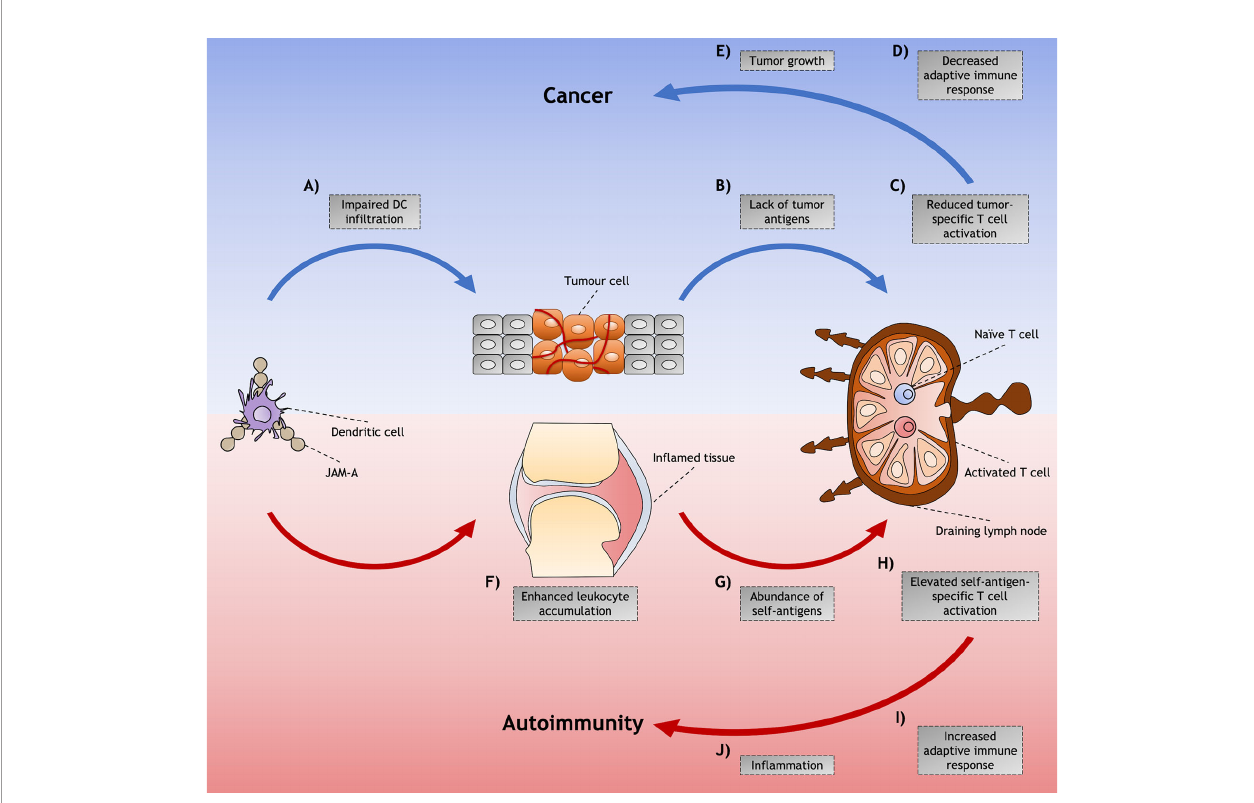
FIGURE 2 | Proposed model for junctional adhesion molecule-A (JAM-A)-mediated dendritic cell (DC) role in cancer and autoimmunity. Although JAM-A may contribute to disease through diverse cell types and signaling processes, mechanisms of DC traf fi cking mediated by JAM-A and their indirect effects in the immune response might play an important role in the induction and/or promotion of cancer and autoimmunity. Among these is the (A) impaired in fi ltration of DCs that is found in tumors that have achieved the hallmarks of cancer. (B) This diminished presence of DCs impairs the availability of tumor antigens that would be presented to tumor-speci fi c T cells in the LNs, (C) leading to reduced T cell activation and (D) decreased adaptive immune responses against the abnormal cells. (E) The lack of immunity against these cells allows tumor to grow and cancer to be set. (F) On the other hand, in autoimmunity, JAM-A may assist the accumulation of immune cells in the in fl amed tissues by enhancing leukocyte adhesion to the in fl amed endothelia. (G) The accumulation of DCs increases the availability of self-antigen not only in peripheral tissues - such as arthritic joints of RA patients, where antigen presentation can occur - but also in the draining LN, by DCs carrying self-antigen captured in the affected tissue. (H) This abundance of self-antigens possibly leads to the activation of a higher proportion of self-antigen speci fi c T cells. (I) The induction of adaptive immune responses against self-antigens leads to (J) in fl ammation and tissue destruction characteristic of autoimmune